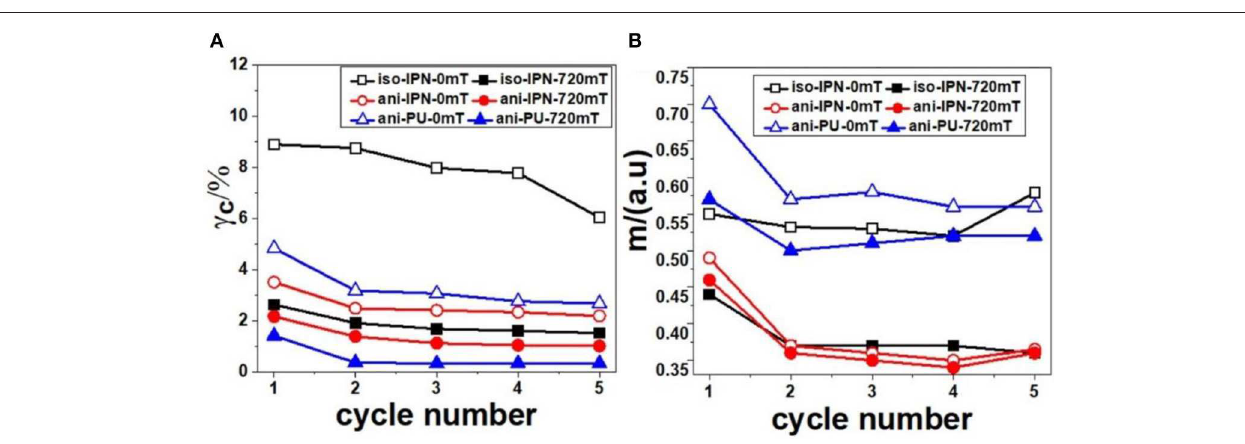
FIGURE 9 | Cycle number dependence of the critical strain γ c (A) and fitting parameter m (B) . The hollow symbol and solid symbol indicated the tests under 0 and 720 mT,